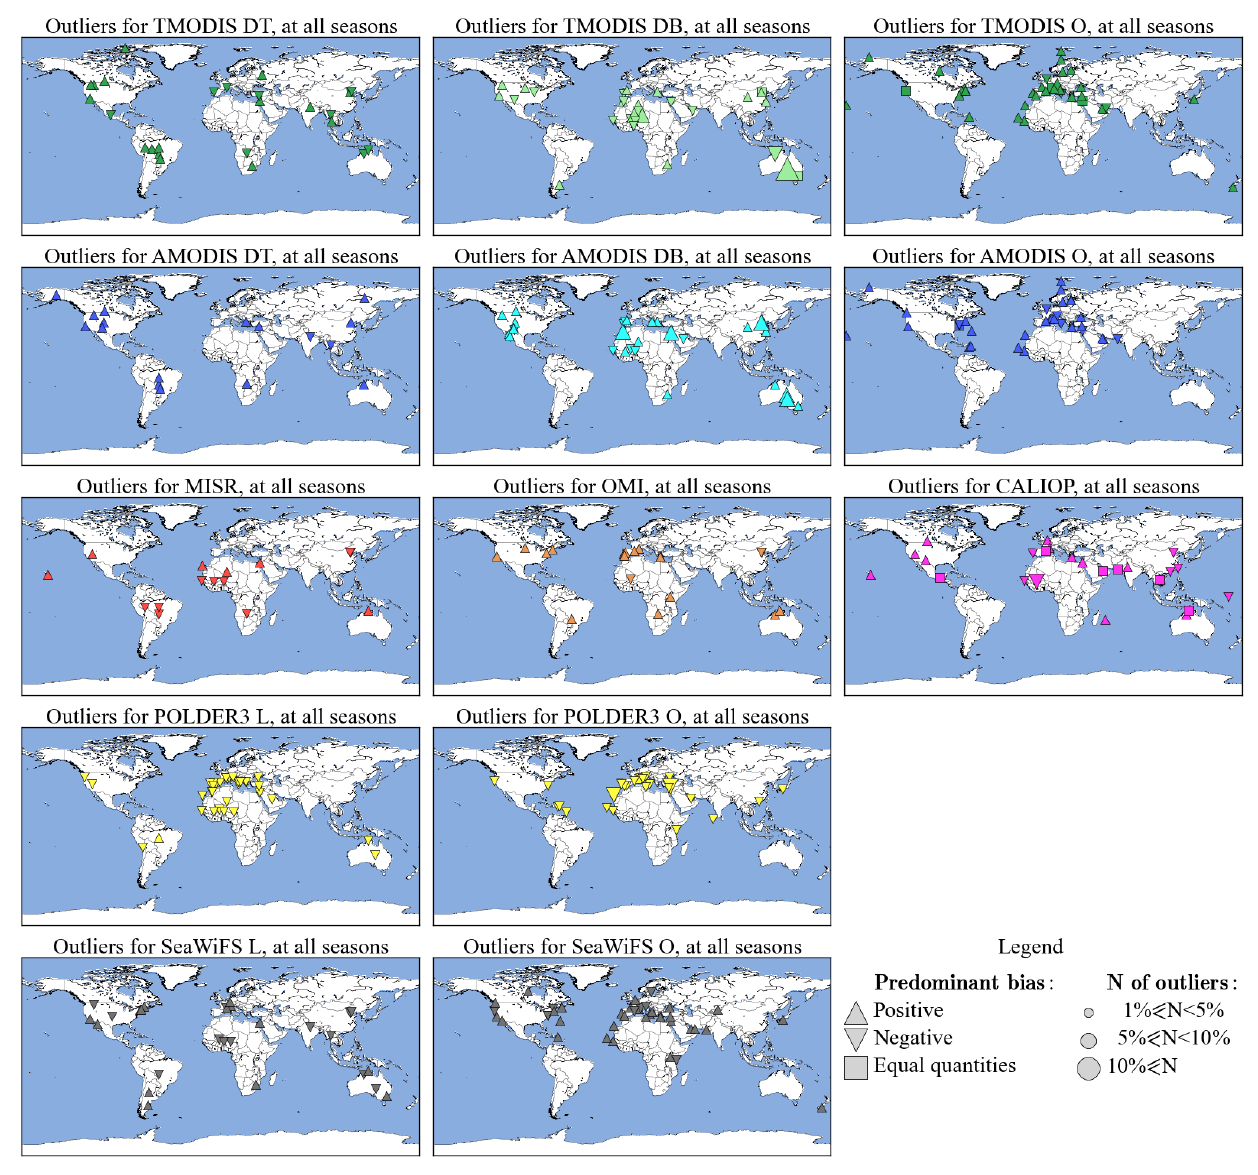
Fig. 9. Distribution of the possible data outliers for the studied spaceborne aerosol datasets. Displayed values are percentages from all outliers detected for each of the datasets as listed in the fourth column of Table 3. Stations with less than 1% from the total number of outliers are not shown. The statistical technique for detection and removal of the possible data outliers is described in Sect. 5.